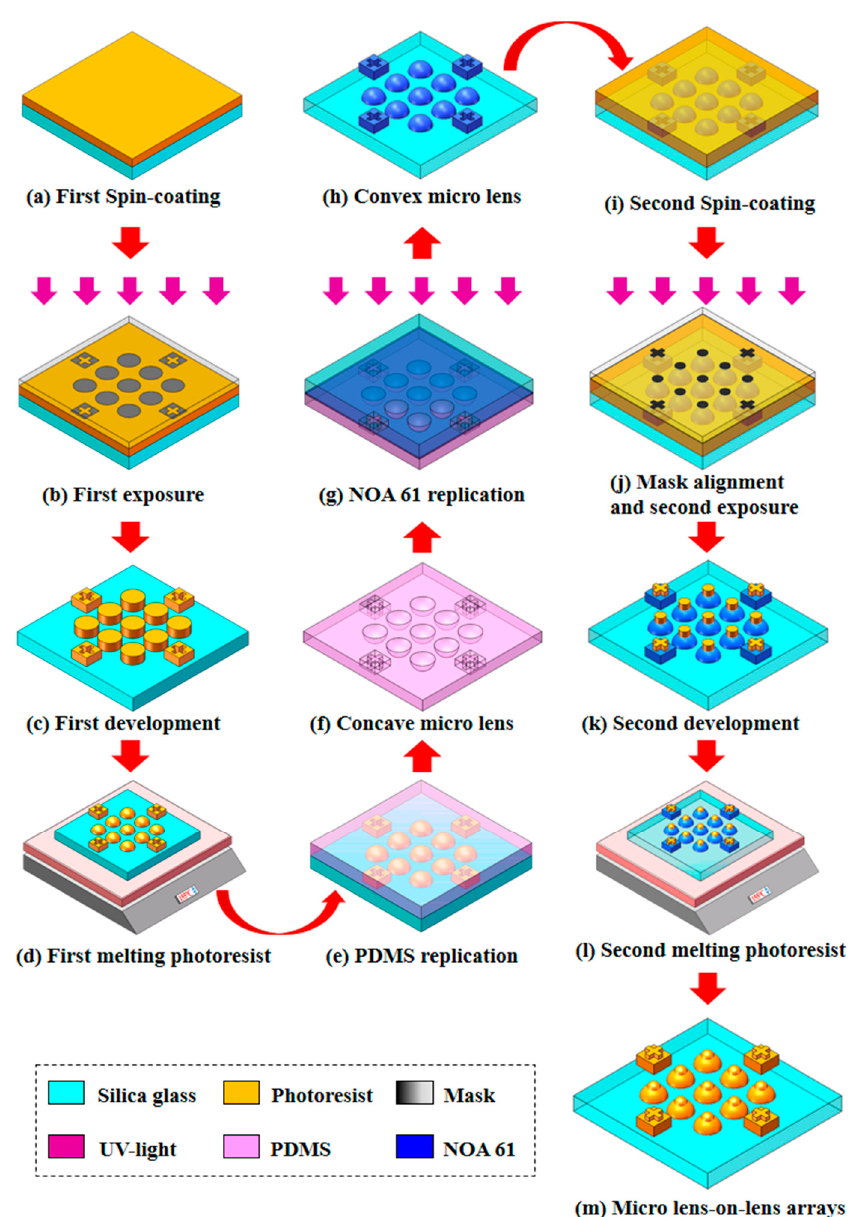
Figure 3. Schematic of the fabrication processes for MLLAs. ( a – d ) Fabricated lower-layer microlens arrays using the photoresist reflow method, including spin-coating the photoresist on the silica substrate, first exposure with the first mask, development and photoresist reflow. ( e , f ) Replica process of the microlens arrays on PDMS surface by soft lithography technology. ( g , h ) Replica process of the microlens arrays on the NOA61 surface using nano-imprint technology. ( i – l ) Fabricated upper-layer microlens arrays using mask alignment exposure technology with the second mask and photoresist reflow. ( m ) The fabricated MLLA